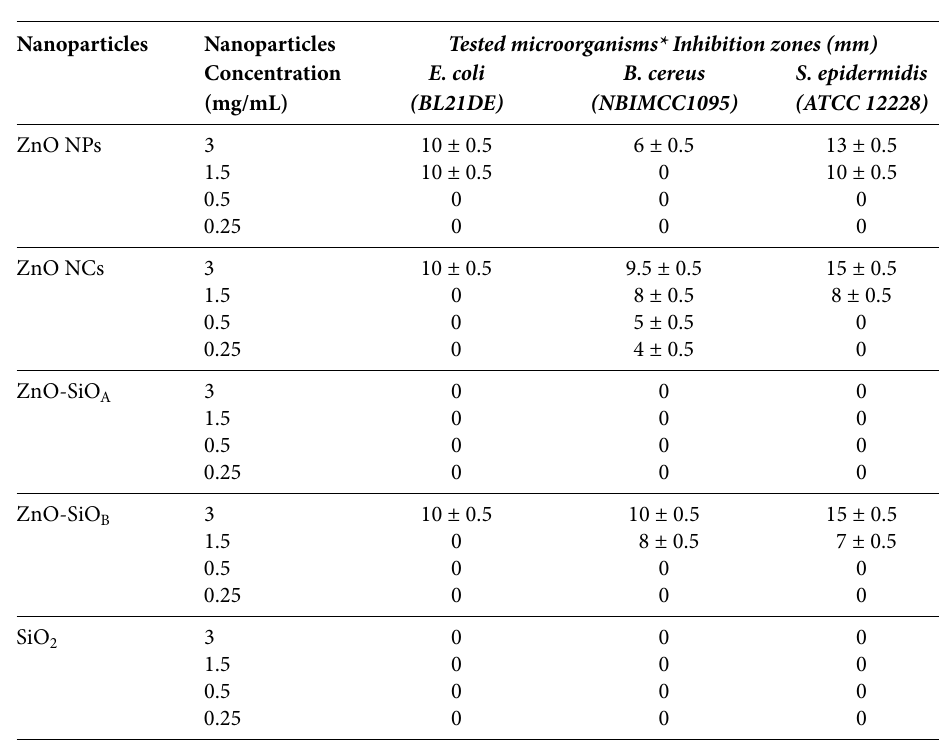
Table 2. Inhibition zones (mm) of the tested